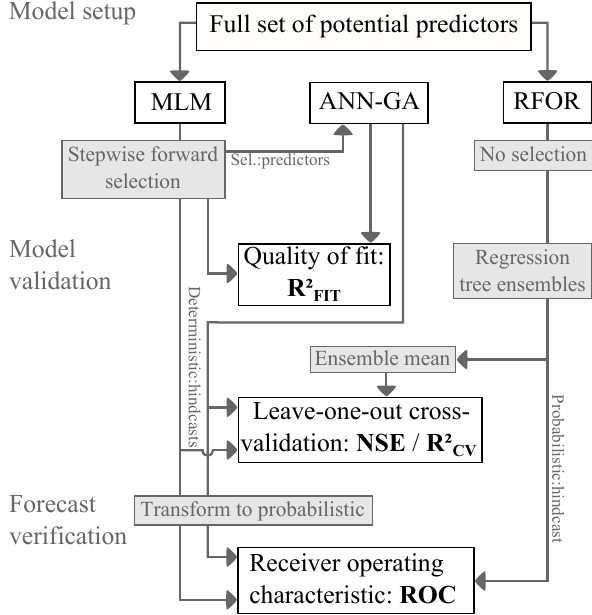
Figure 3. Modelling and validation scheme to account for the dif- ferences in models: MLMs, ANN-GAs and RFORs. The predictors selected for the MLMs are also used in the ANN-GAs, whereas RFOR works with the complete predictor set. MLMs and ANN- GAs are deterministic and require transformation to probabilistic form, whereas RFOR is probabilistic and is transformed to a deter- ministic value for the purpose of forecast comparison. Deterministic forecast skill is assessed using the coefficient of determination R 2 the probabilistic properties are analysed using the ROC